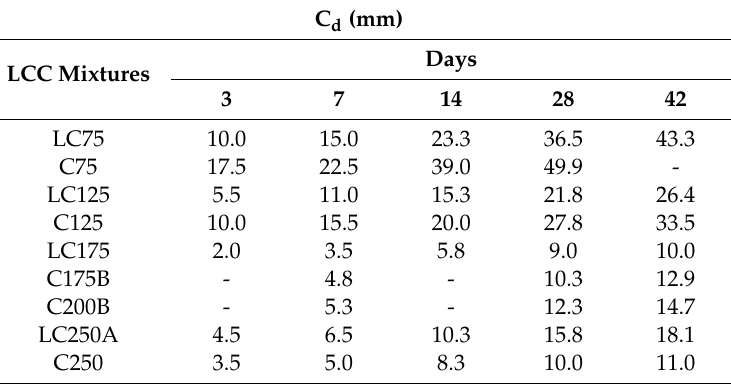
Figure 19. Relationship between C d vs. W/C eq .